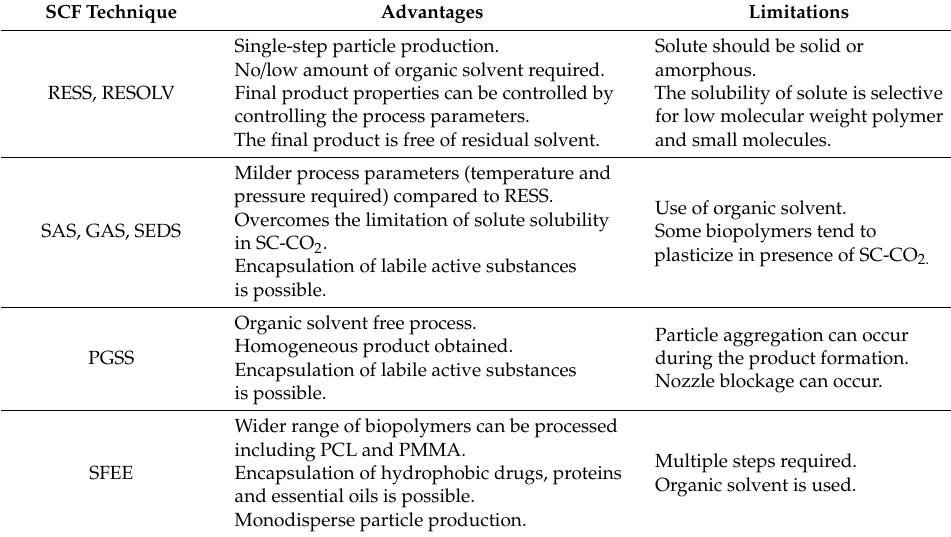
Table 1. Overview of advantages and limitations of the SC-CO2-based